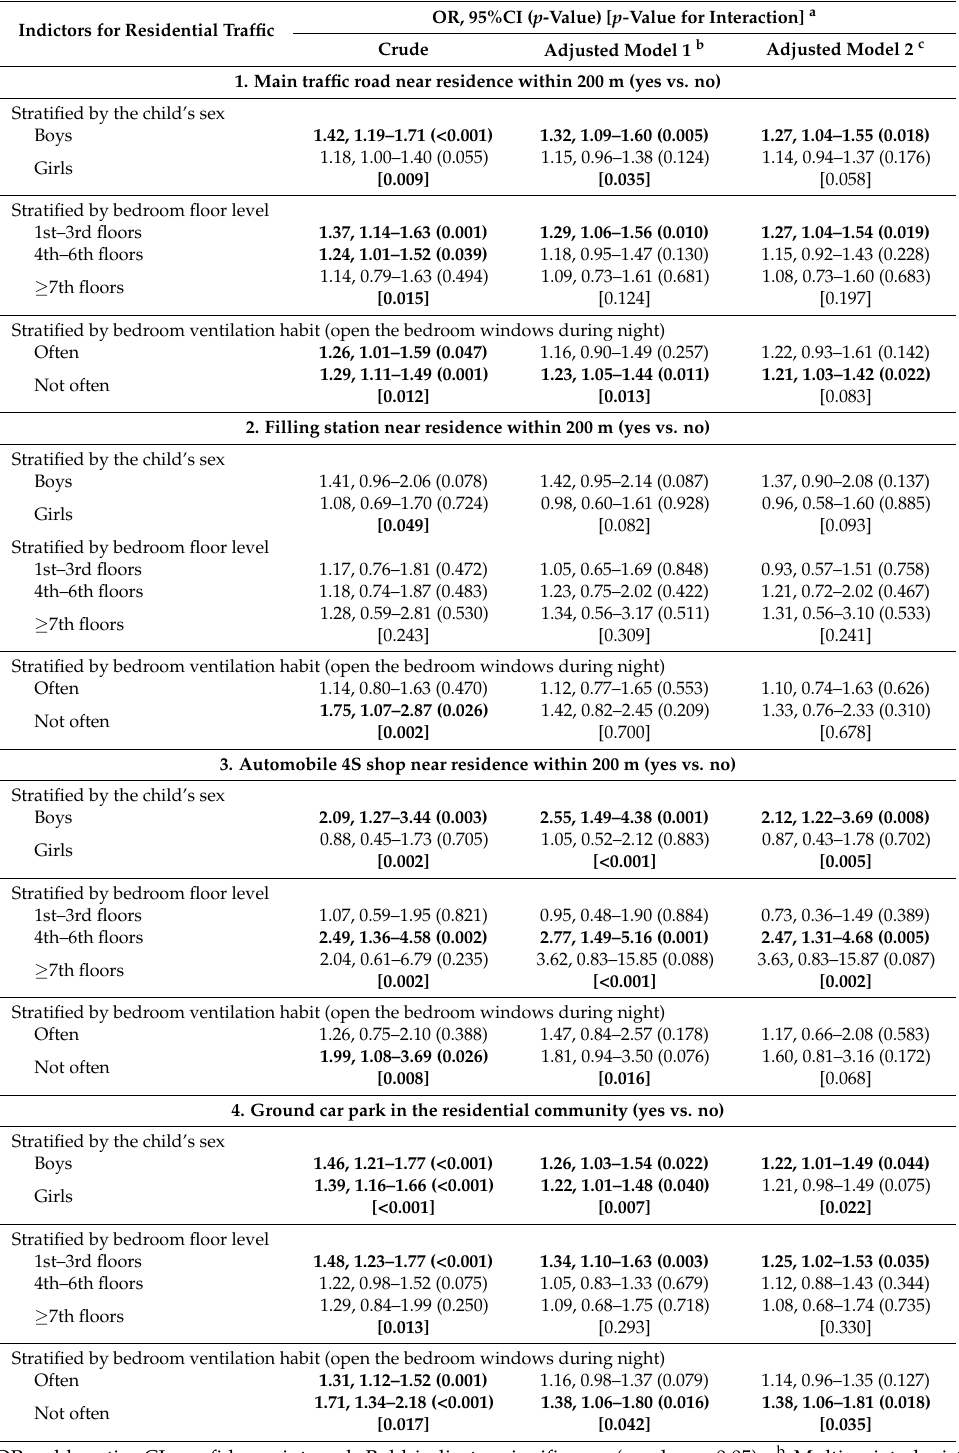
Table 4. Associations of childhood pneumonia with residential traffic in the logistic regression analyses in the subgroups, stratified by the child’s sex, bedroom floor level, and bedroom ventilation habit. Indictors for Residential